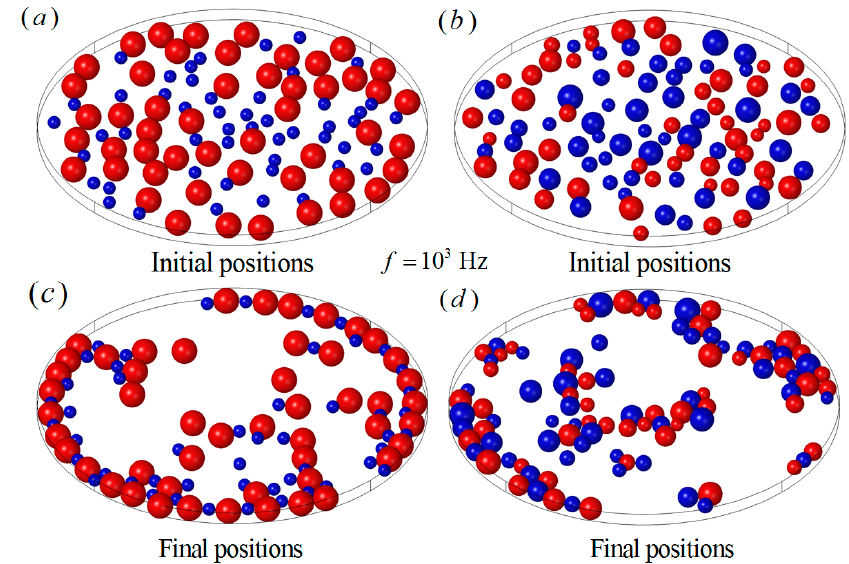
Figure 11. The particle chains with different particle sizes and conductivities when f = 10 3 Hz. ( a ) The initial particle positions of two different sizes, half of the particles with radius a ∗ = 1 and the other half of the particles with radius a ∗ = 2; ( b ) the initial particle positions of random particle sizes from a ∗ = 1 to a ∗ = 2; ( c ) the particle chains of two different sizes; ( d ) the particle chains of random particle sizes.